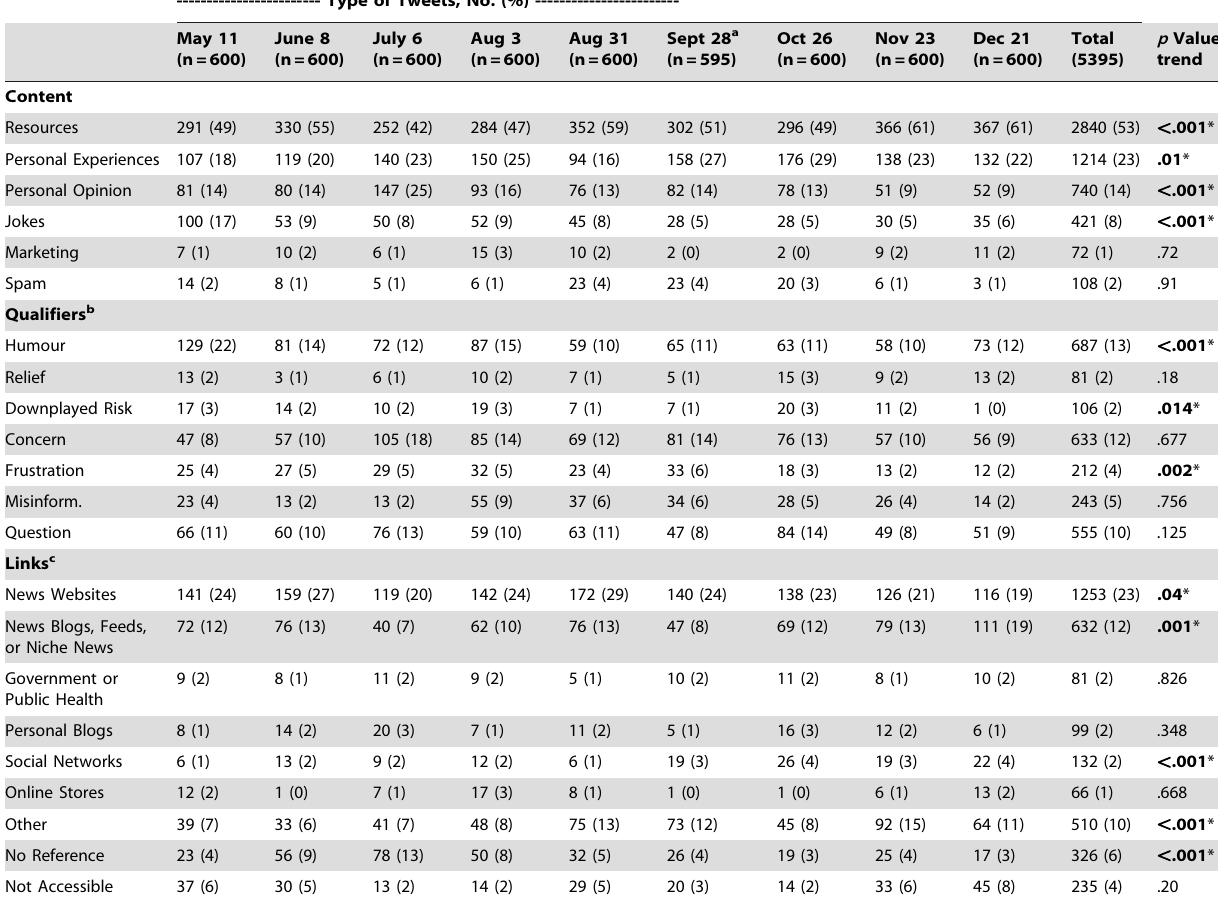
Table 4. Content, Qualifiers, and Links of Manually Coded H1N1